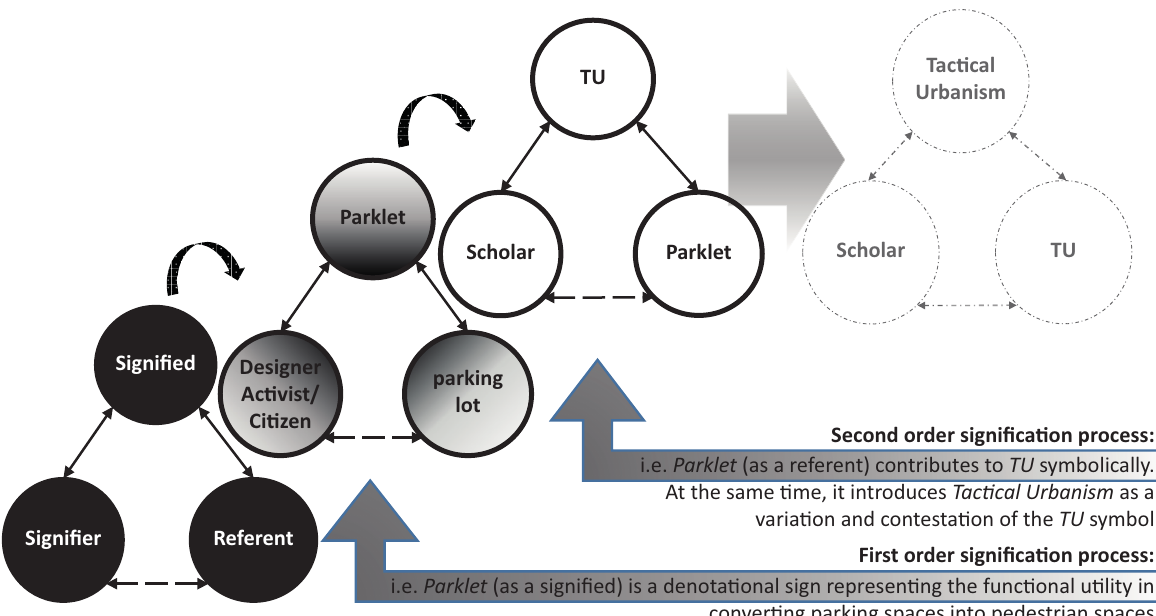
Figure 4. Illustration of the first and second order of signification through which ‘parklet’ as a semiotic mechanism switches positions, and ‘tactical urbanism’ is introduced as a variant of the ‘TU’